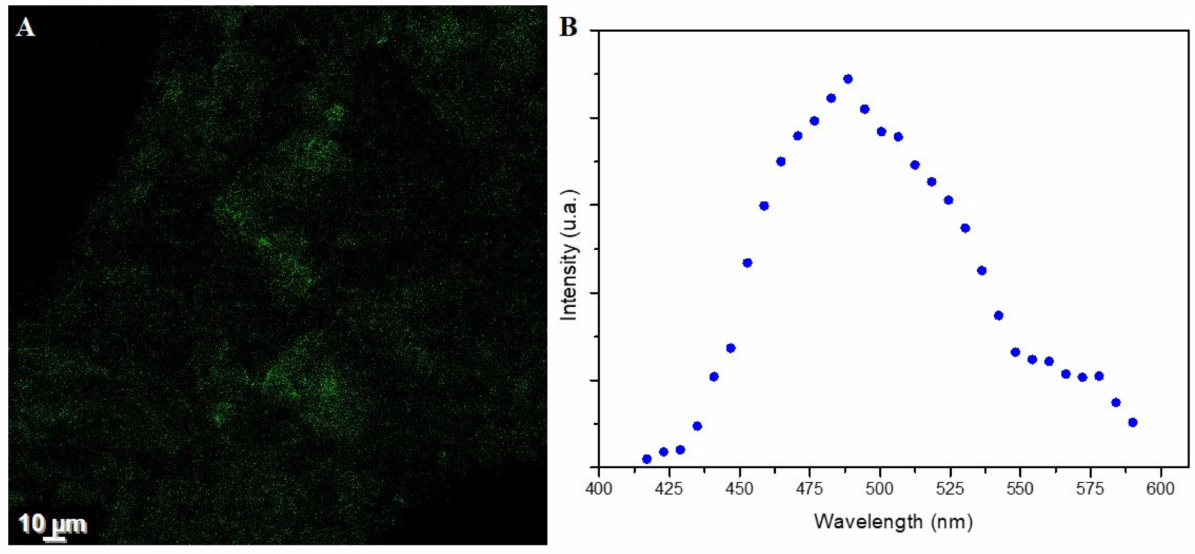
Figure 5. ( A ) Confocal microscopy images of B. haynesii CamB6 melanin and ( B ) fluorescence spectra of the sample.